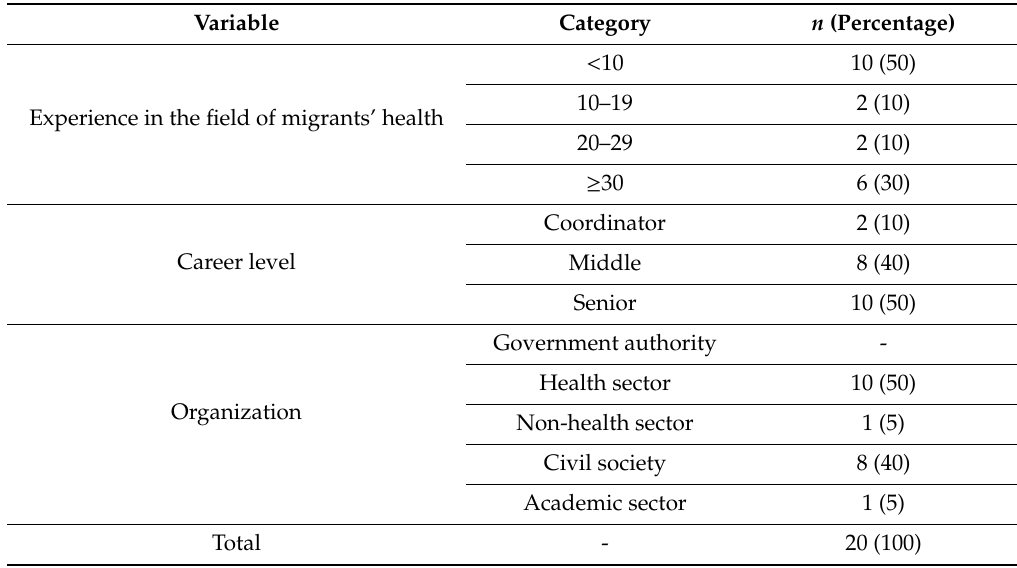
Table 1. Socio-demographic characteristics of stakeholders engaging in the 1st and 2nd